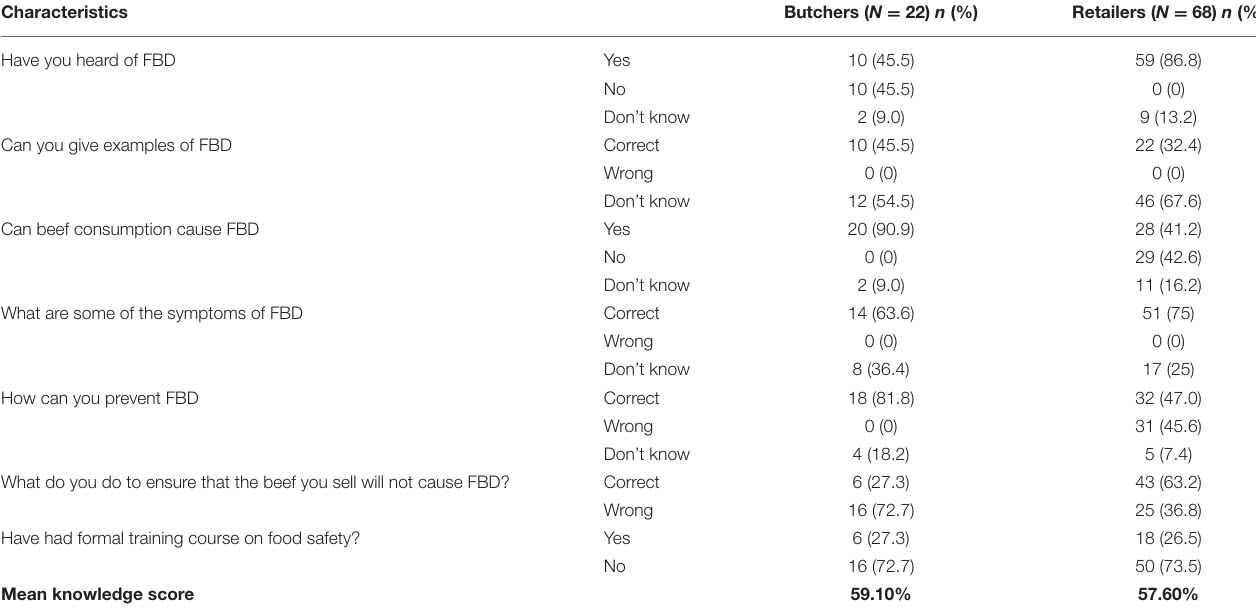
TABLE 2 | Knowledge level score of Butchers and Retailers on Foodborne disease and food safety.